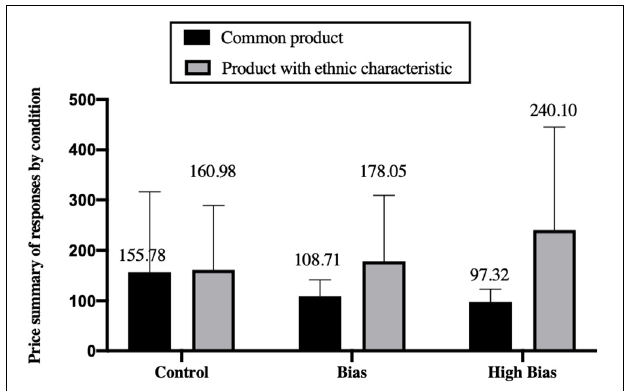
FIGURE 3 | Price summary of responses by condition.